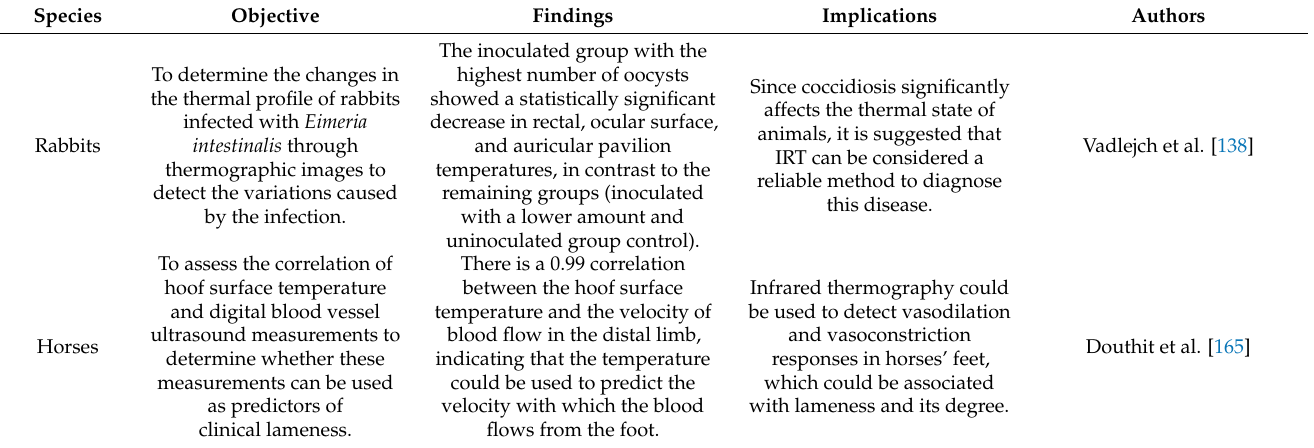
Table 1. Recent advances related to different pathologies in farm animals through the use of IRT. Species Objective Findings Implications Authors To determine the changes in the thermal profile of rabbits infected with Eimeria intestinalis through Rabbits thermographic images to detect the variations caused by the infection. To assess the correlation of hoof surface temperature and digital blood vessel ultrasound measurements to Horses determine whether these measurements can be used as predictors of clinical